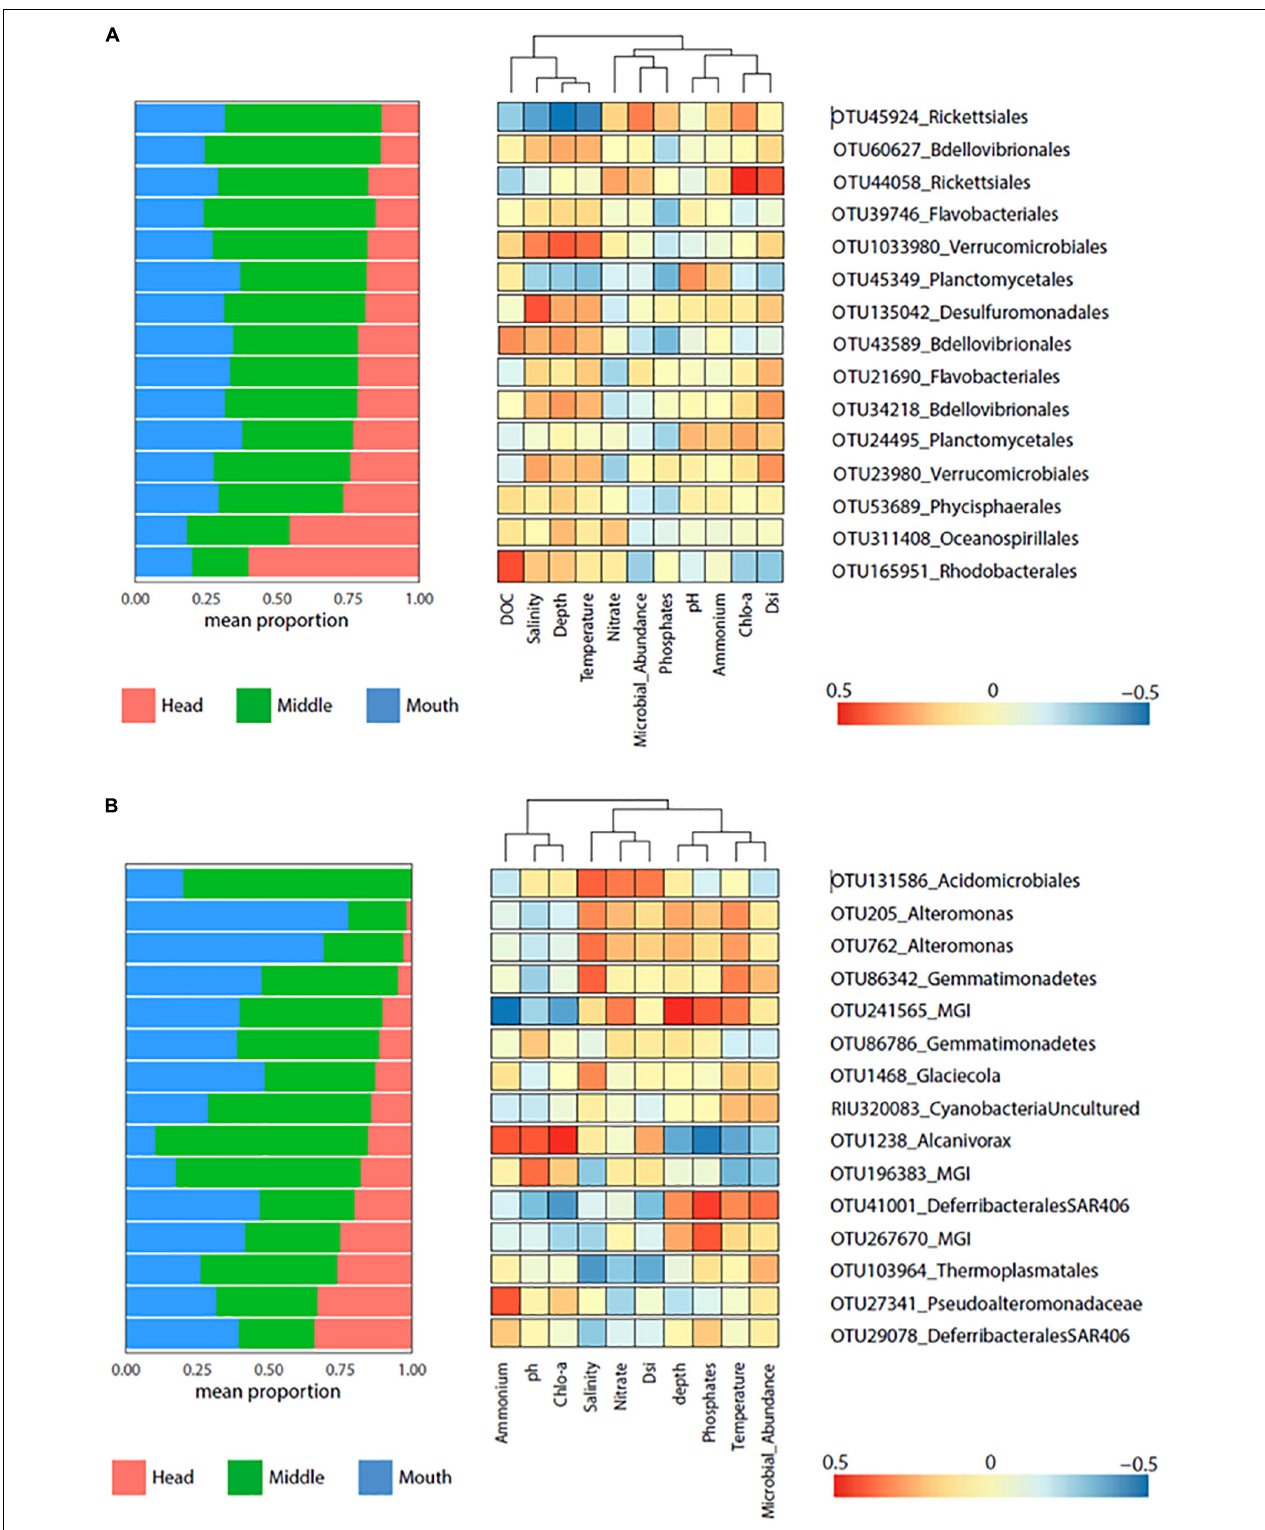
FIGURE 7 | Heatmap displaying the indicator species ( p = 0.001) for Yendegaia fjord 2017 (A) and 2018 (B) . Left panel shows the mean relative contribution of the indicator species to microbial community detected by stations (head, middle, and mouth). Right panel shows heatmap of Pearson correlation between indicator species (OTU abundance) and environmental